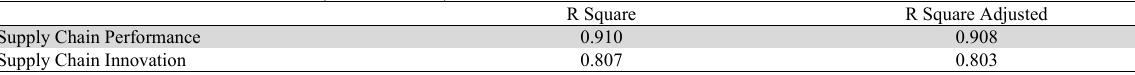
Evaluation of the Structural Model (Inner